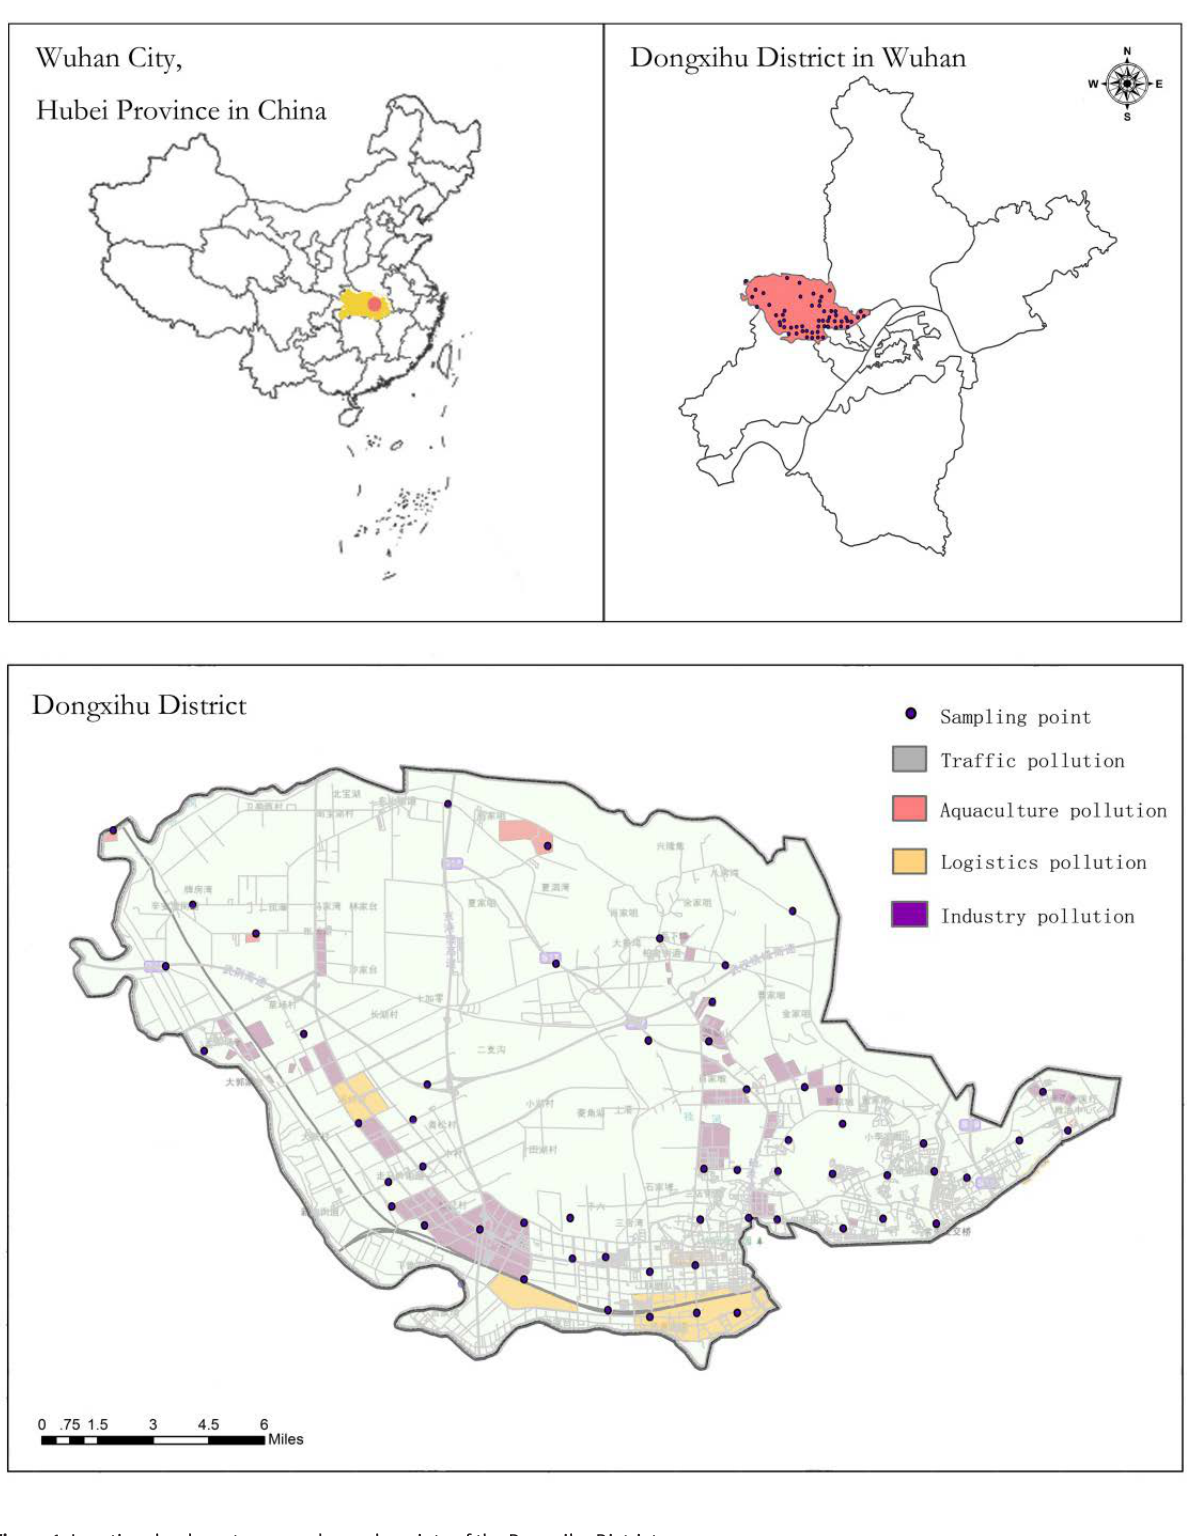
Figure 1: Location, land use types, and sample points of the Dongxihu